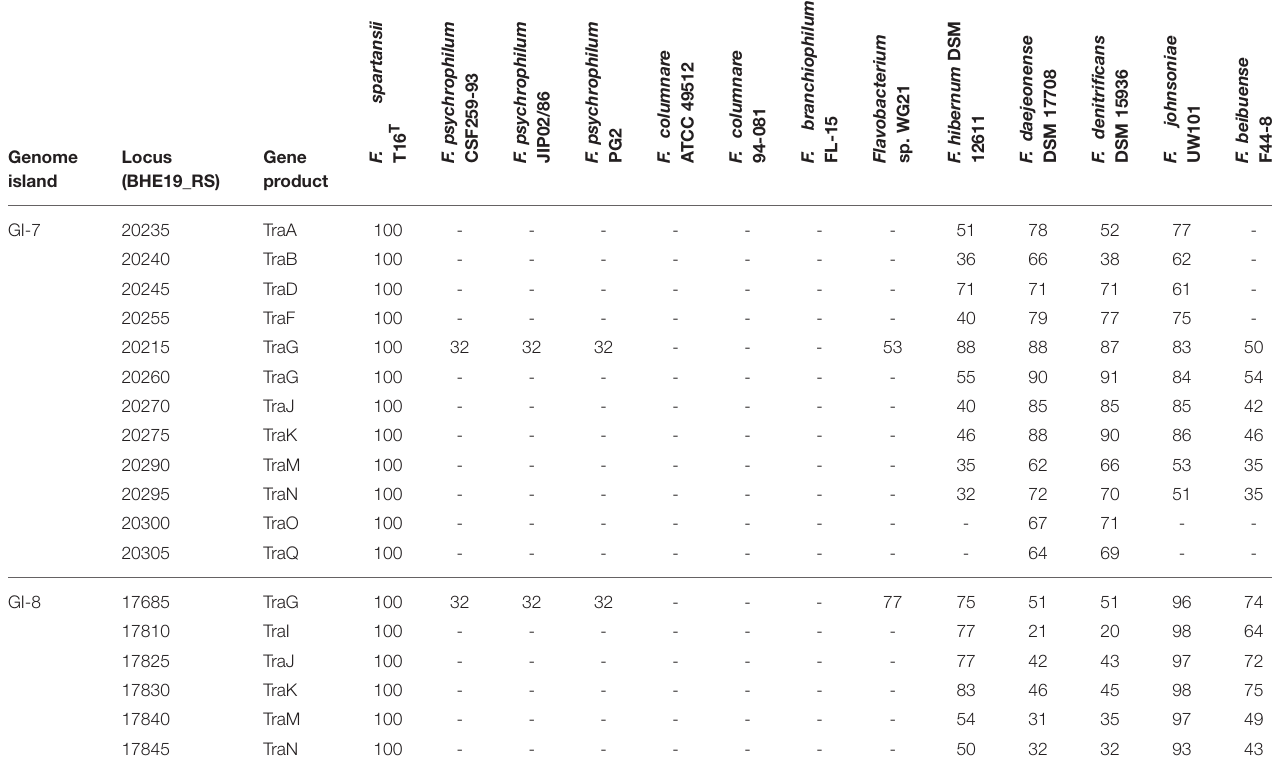
TABLE 4 | Transfer proteins in the selected Flavobacterium spp.*.